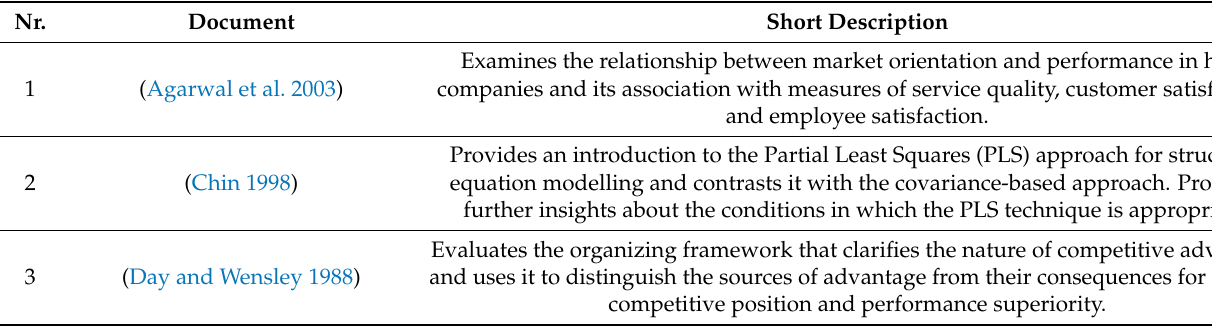
Table 2. Short descriptions of the cluster 1